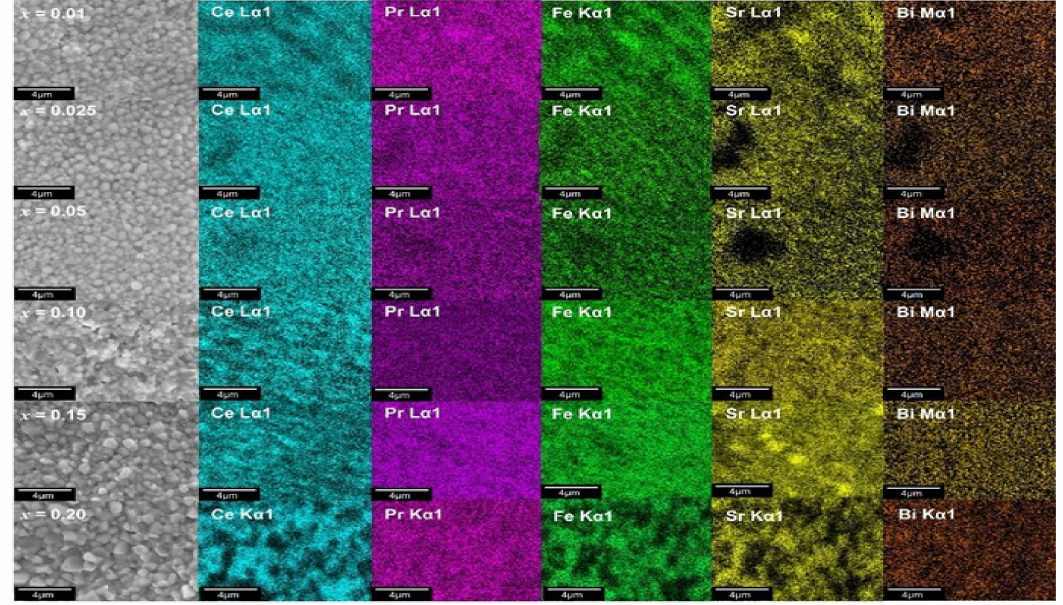
Figure 4. EDXS images of the elemental distribution of 60CPO-40PSF 1 − x B x O membranes after sintered for 5